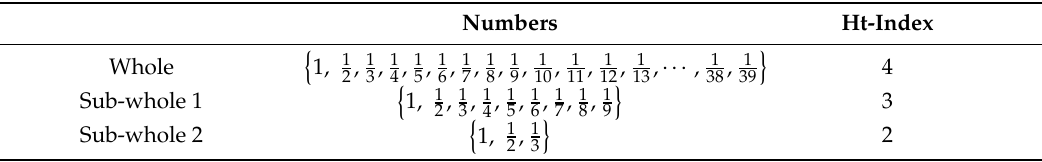
Table 1. A typical whole, the sub-wholes belonging to the whole, and their ht-indices.